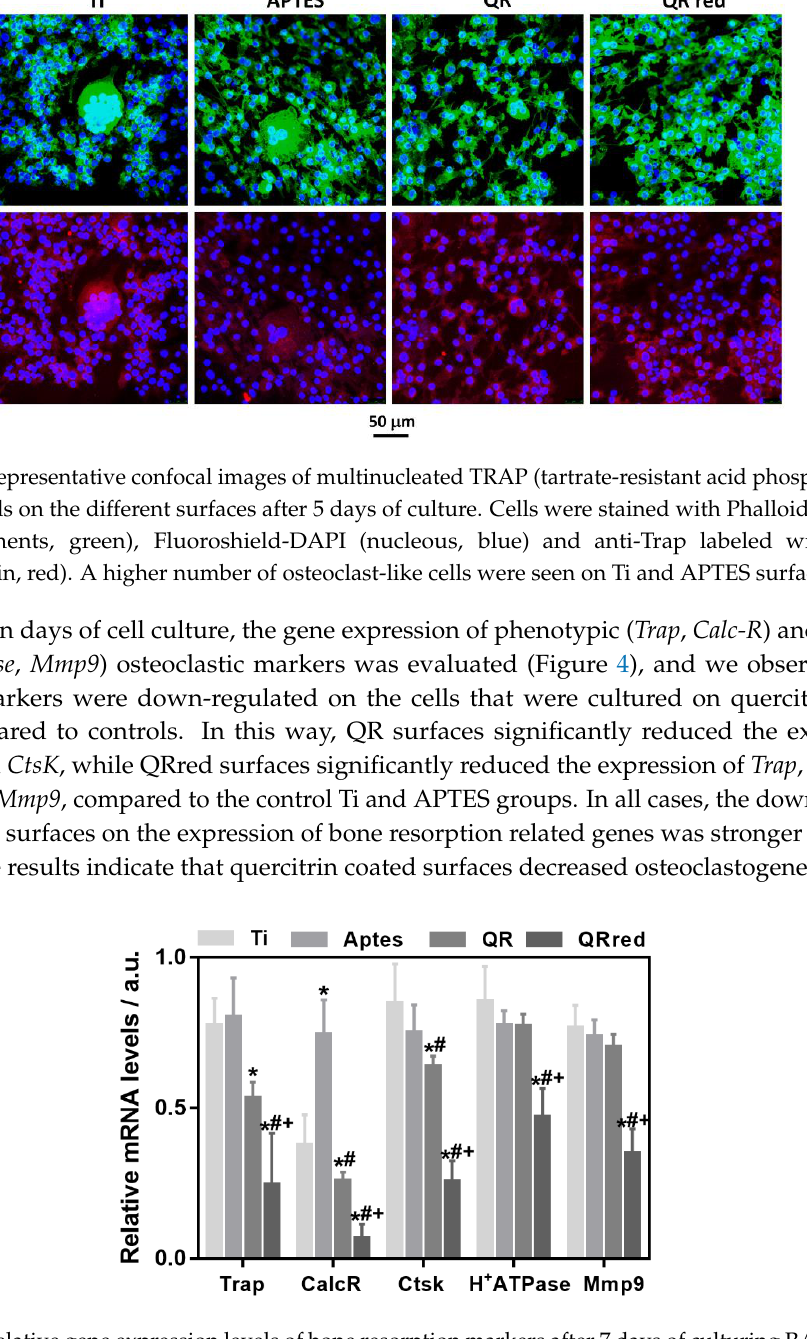
Figure 4. Relative gene expression levels of bone resorption markers after 7 days of culturing RAW264.7 cells in vitro with RANKL (receptor activator of nuclear factor kappa-B ligand). Tartrate-resistant acid phosphatase ( Trap ) and calcitonin receptor ( CalcR ) were analyzed as phenotypic markers, and cathepsin K ( Ctsk) , vacuolar type proton ATPase ( H + ATPase ) and metalloproteinase 9 ( Mmp9 ) as functional osteoclastic markers. Values represent mean ± SEM, n = 6, a.u. (arbitrary units). t -test: * p < 0.05 vs. Ti, # p < 0.05 vs. APTES, + p < 0.05 vs.